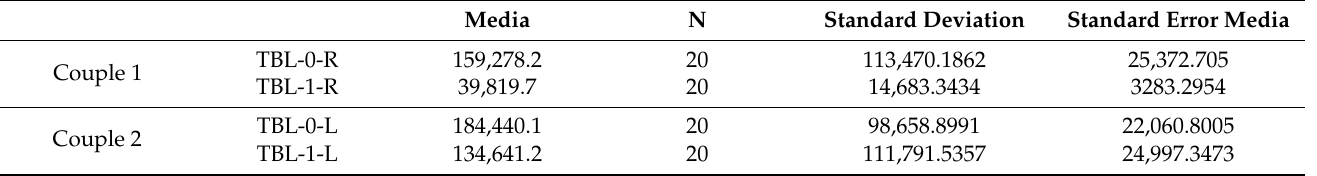
Table 1. In right (R-SRP plus ALADENT) and left (L-SRP)